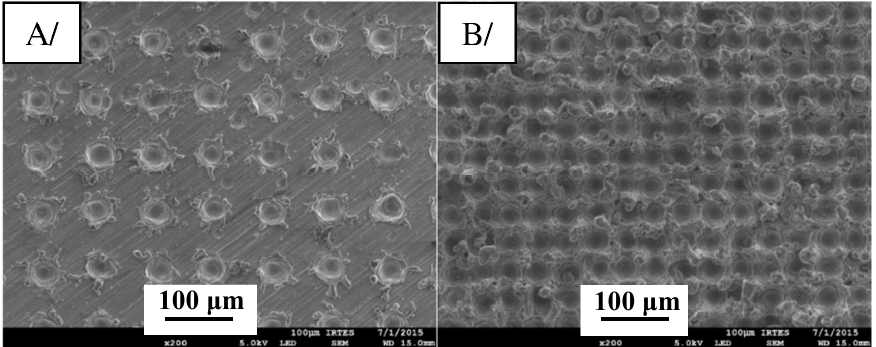
Figure 12. The pore structure of the laser micro-texture on the surface of the cold-sprayed substrate. ( A ) Texture 1 (LST1) and ( B ) texture 2 (LST2) [86].